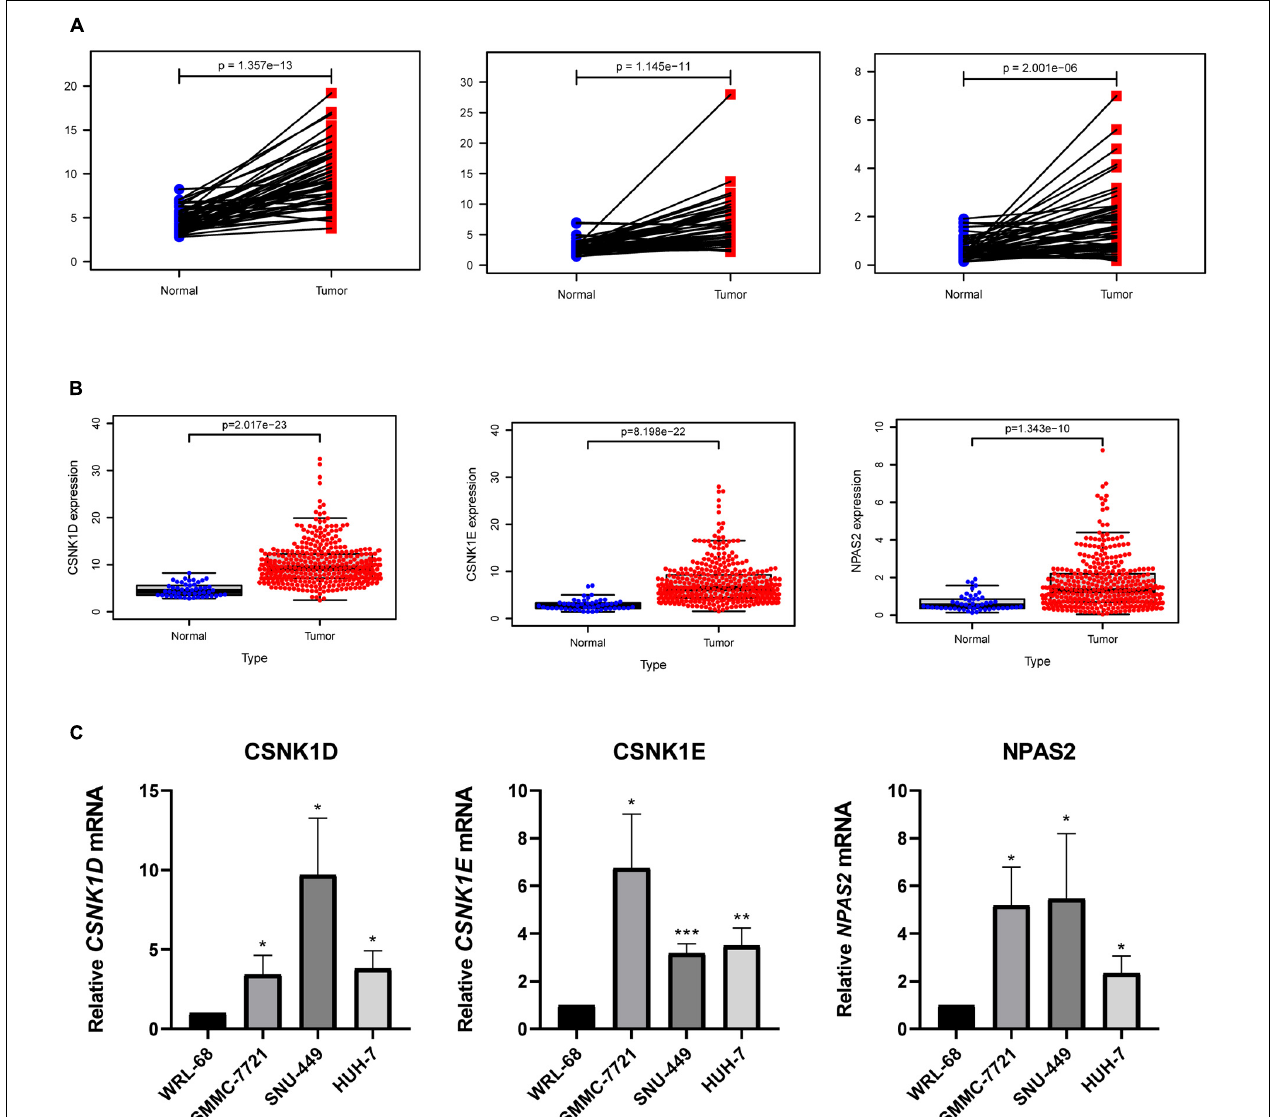
FIGURE 6 | Expression levels of 3 hub genes in LIHC. (A) CSNK1D , CSNK1E , and NPAS2 expression levels in normal and LIHC tissues. (B) CSNK1D , CSNK1E , and NPAS2 expression levels in LIHC tissues and their matched controls. (C) The mRNA expression levels of CSNK1D , CSNK1E , and NPAS2 in LIHC cell lines. The experiments were performed independently for three times. * P < 0.05, ** P < 0.01, *** P <